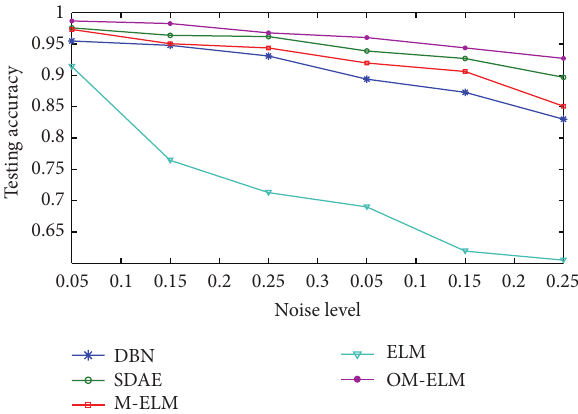
Figure 7: Testing accuracy versus noise level of five methods.